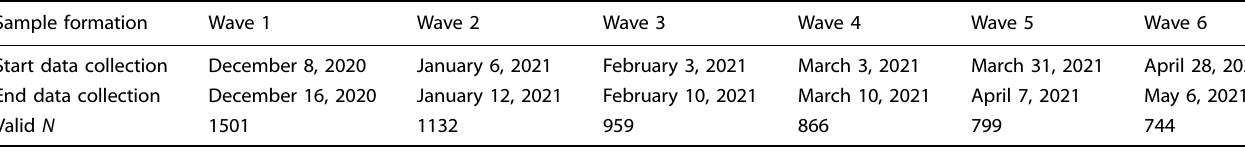
Table 4. Speci fi cations per wave leading up to the fi nal longitudinal sample ( N = 744). Sample formation